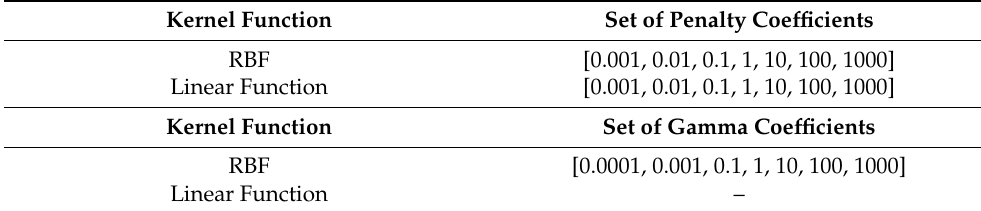
Table 4. Model comparison between MAE and RMSE.